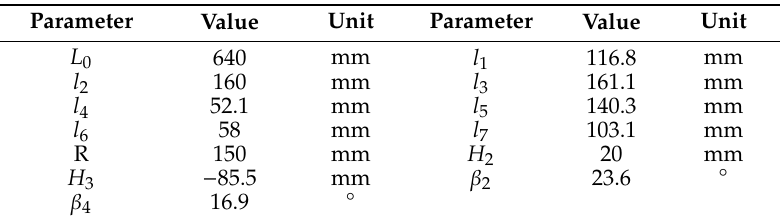
Table 1. Parameters of the active suspension.